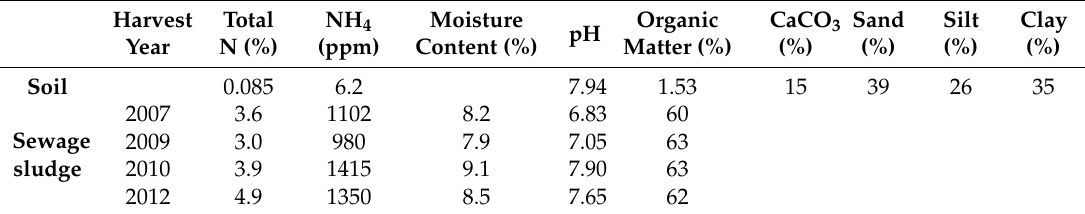
Table 5. Some physical and chemical properties of the soil in the experimental site and the incorporated sludge at the beginning of each three-year